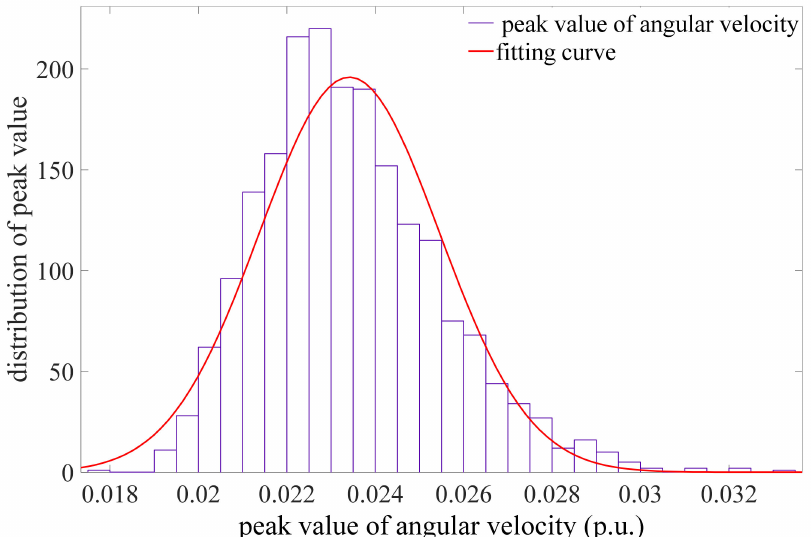
Figure 20. Distribution of the peak value of the angular velocity.